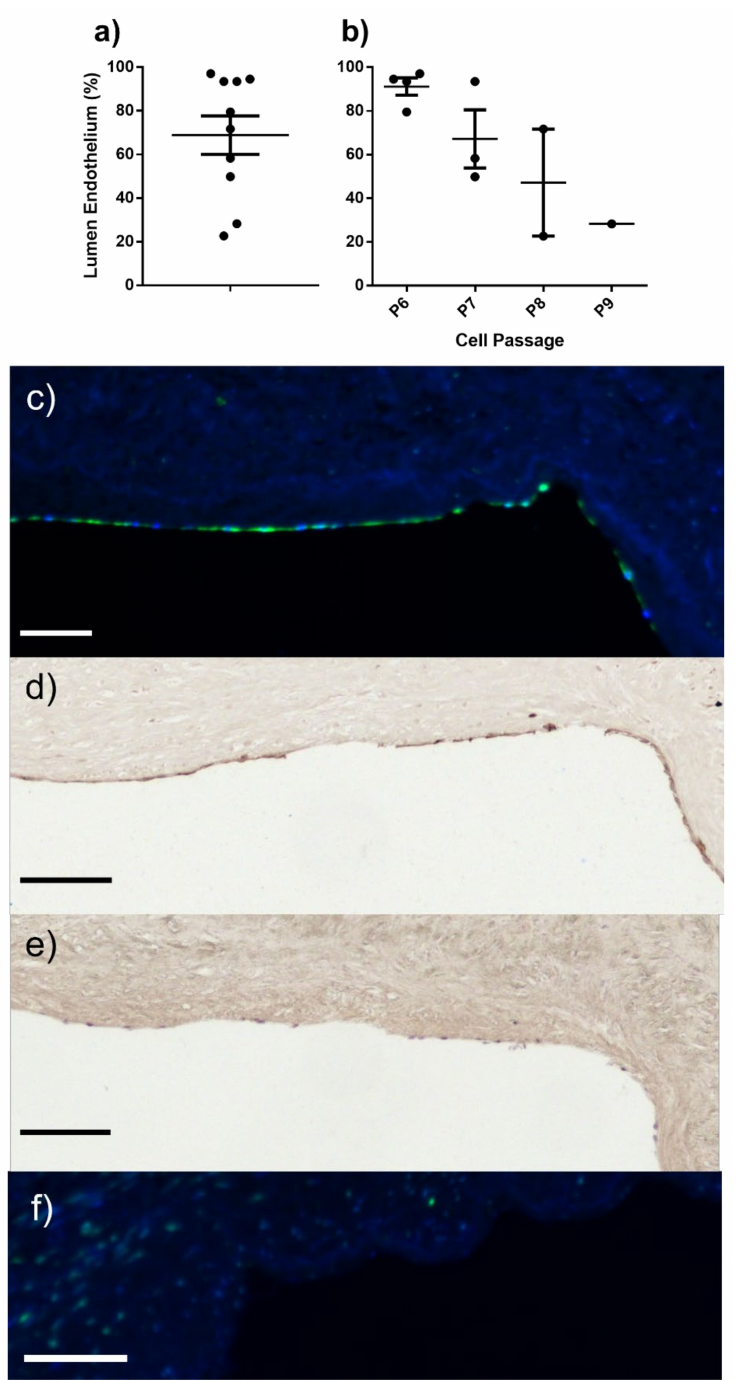
Figure 4. Seeding endothelial-like cells (ELC) onto decellularised human saphenous vein. ( a ) Per- centage of lumen covered by ELC following 96 h on a roller at 1 rpm and a further 72 h in static culture in ( a ) all seeded vessels and ( b ) lumen coverage for each cell passage used. Error bars in- dicate standard error of the mean. Representative serial section images of ELC on lumen, stained with ( c , f ) DBA-Lectin (green) and DAPI (blue), ( d ) CD31 (dark brown), and ( e ) H&E for nuclei. ( f ) Unseeded decellularised human saphenous vein. Black and white scale bars represent 100 µ